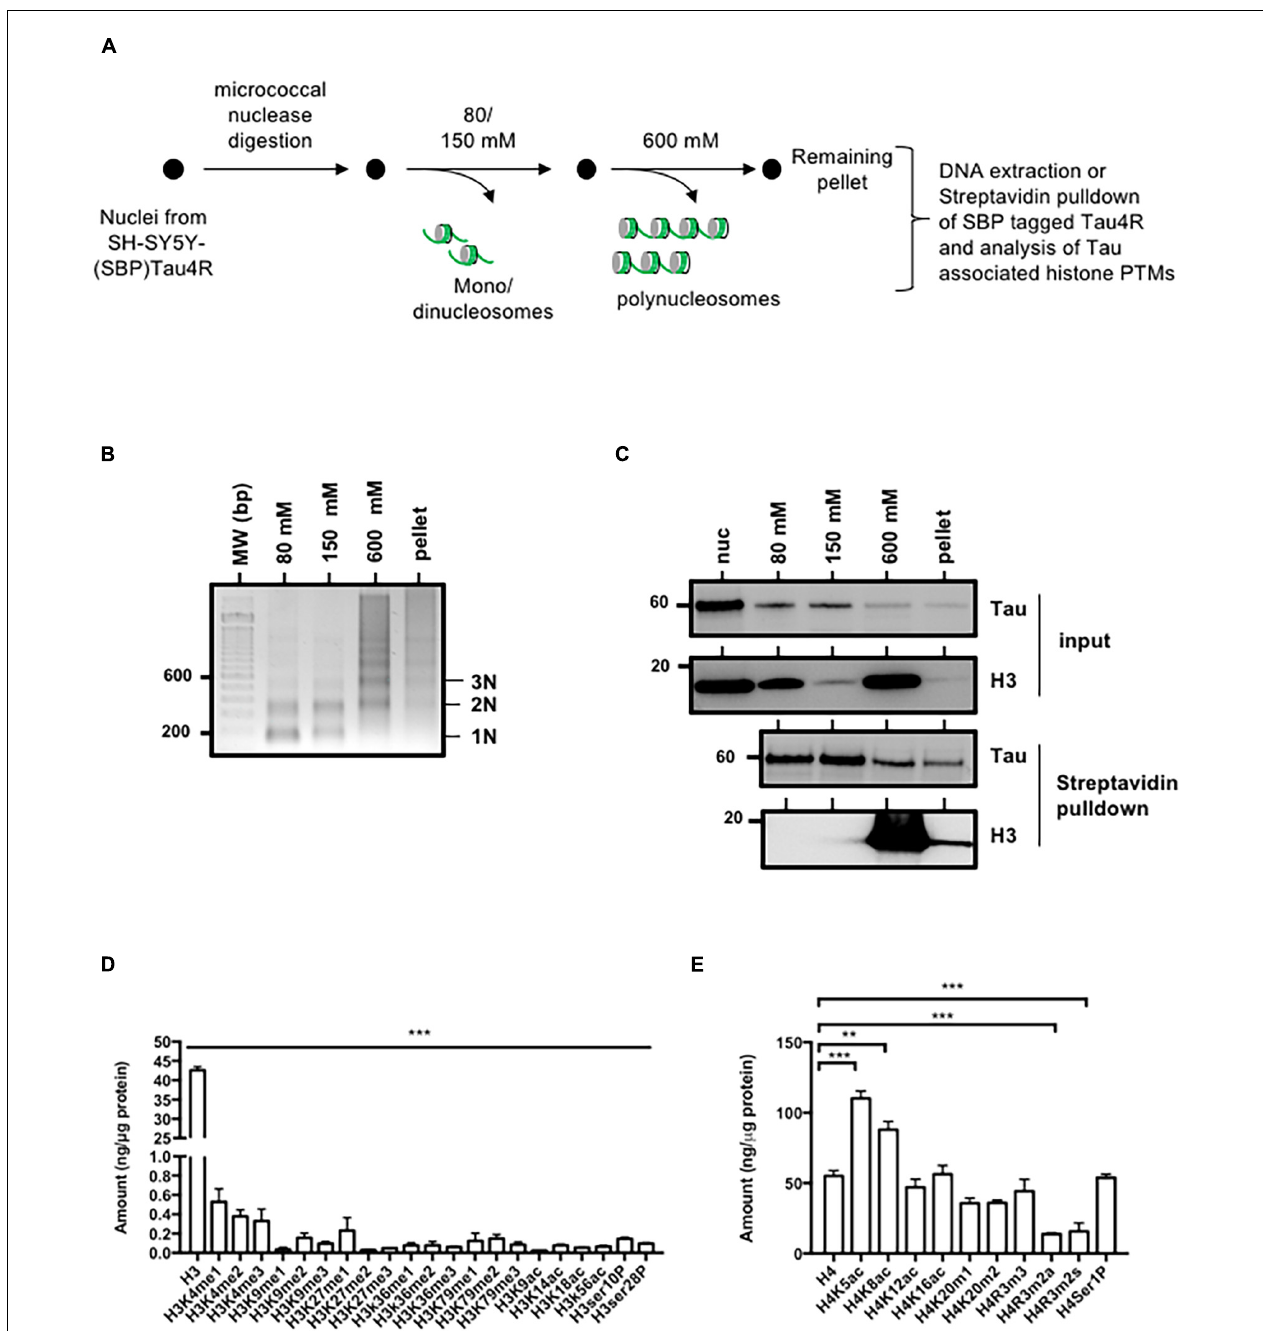
FIGURE 4 | Tau4R is associated with condensed chromatin. (A) Schematic representation of salt fractionation of nucleosomes steps. Nuclei were isolated and digested with micrococcal nuclease and extracted successively with the indicated NaCl concentration. (B) DNA characterization from SH-SY5Y-(SBP)Tau4R cell chromatin fractions. DNA ladder obtained from micrococcal nuclease-treated nuclei purified as described in (A) . Nucleosomes are indicated on the right. (C) Tau interacts with histones in the condensed chromatin and the transcriptionally active fractions. Equal aliquots of each salt fraction were resolved on 12% SDS-PAGE and visualized by immunoblot analysis with antibodies against Tau or H3 (input). The remainder was used for streptavidin pulldown of SBP (streptavidin binding peptide) tagged Tau4R. Bound fractions were resolved on 12% SDS-PAGE and visualized by immunoblot analysis with antibody against H3. (D) Analysis of the different histone H3 or (E) H4 post-translational modifications associated with Tau in the condensed chromatin fraction (600 mM). Eluted Tau4R complex obtained from the 600 mM fraction obtained as described in (A) were analyzed for H3 and H4 post-translational modifications using ELISA kits. Data are mean ± SD, ** P < 0.01, *** P < 0.001. All results are representative of three independent experiments.